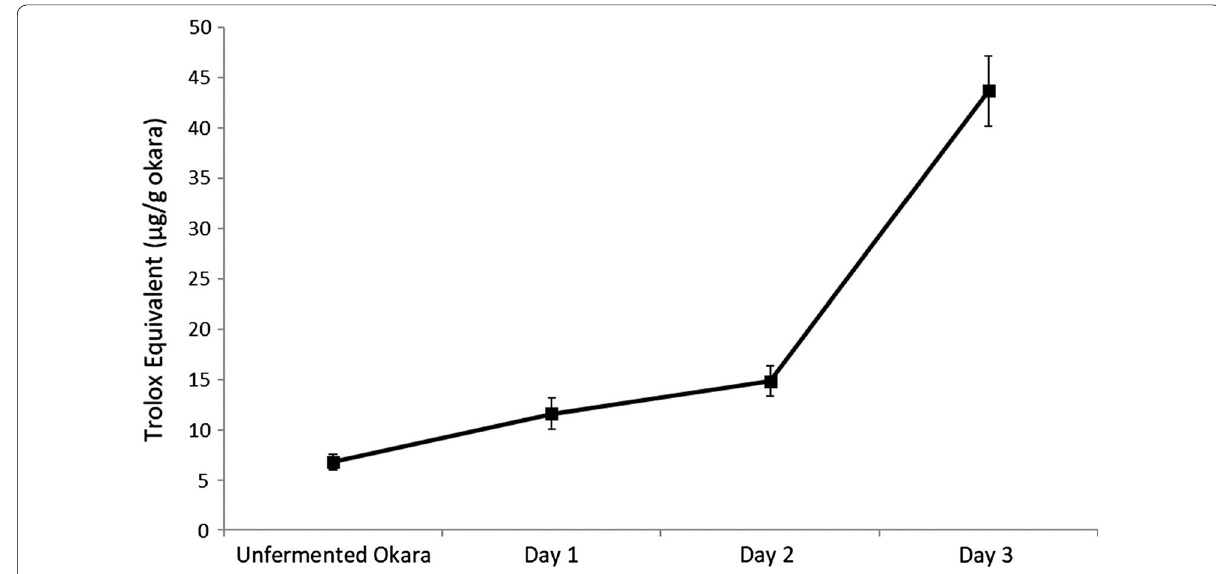
Fig. 5 DPPH scavenging activity of fermented and unfermented okara across 72 h expressed in terms of Trolox equivalent (µg/g